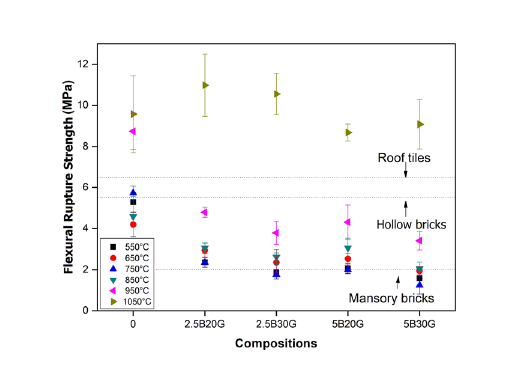
Figure 8. Flexural rupture strength of compositions. The flexural strength, or stress at which the material breaks, is the most important property for structural material and this property increases with the temperature increase, mainly to 1050ºC. As previously discussed, this is due to the sintering mechanisms that allow greater formation of liquid phase, thus reducing the porosity of the material and promoting a better consolidation of the particles. In Figure 8 it is noticed that the blend incorporation causes a decrease in the flexural rupture strength, except for the ones burned at 1050ºC, in which the compositions with the smaller biomass amount (2.5%) cause an increase. The minimum resistance required for the masonry bricks manufacture is 2MPa, for hollow bricks is 5.5MPa and for roof tiles is 6.5MPa 23 . The results obtained at 1050ºC for all compositions are above the minimum strength for manufacturing of these three products. Composition with highest amounts of granite, 2.5B30G and 5B30G, are above the minimum strength for masonry bricks when fired at 550 and 750ºC.